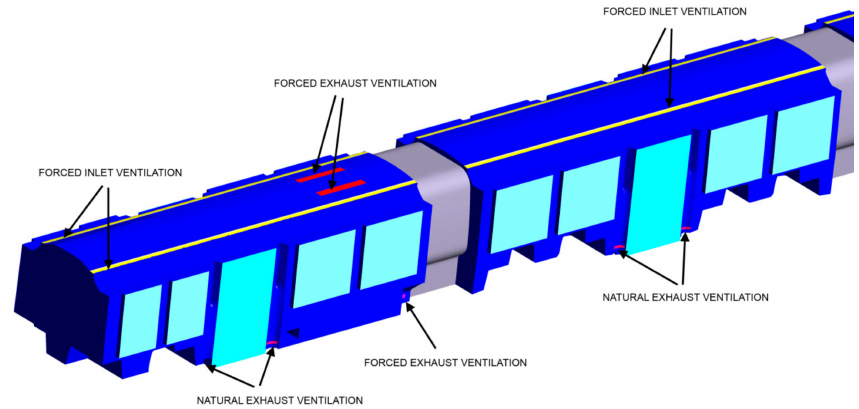
Figure 2. Inlets and exhaust openings, part 1.